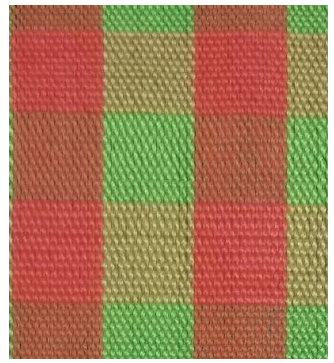
Figure 3. Plain fabric.